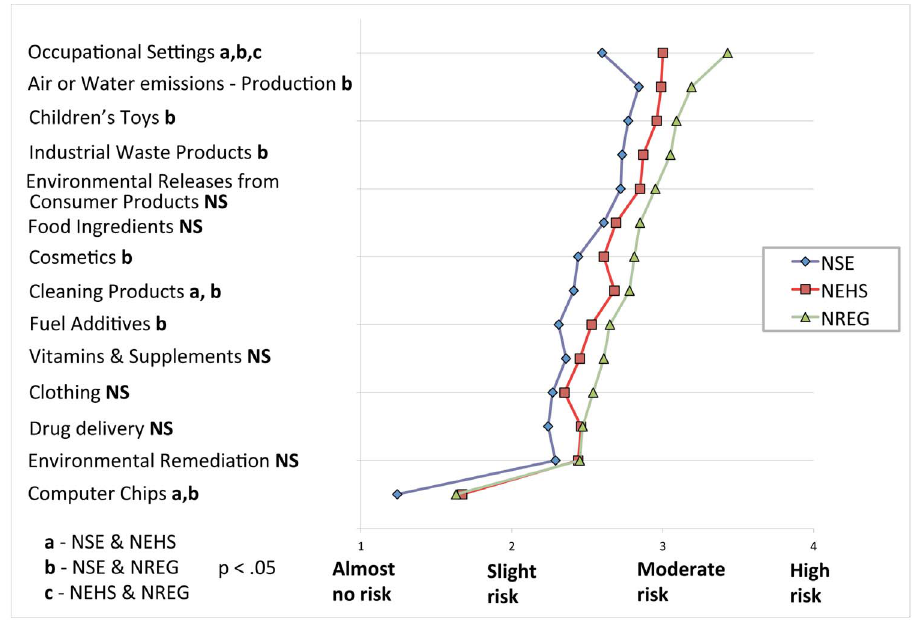
Figure 2. ’Risk Perception’ ratings for NSE, NEHS, and NREG expert groups. Mean scores for each group are indicated with points on respective color-coded lines capturing 14 different nanotechnology scenarios rated between ‘almost no risk’ and ‘high risk’. Significant differences in means were determined using a one-way ANOVA with post hoc analysis, and are indicated with a, b, and c markings as outlined in the legend.